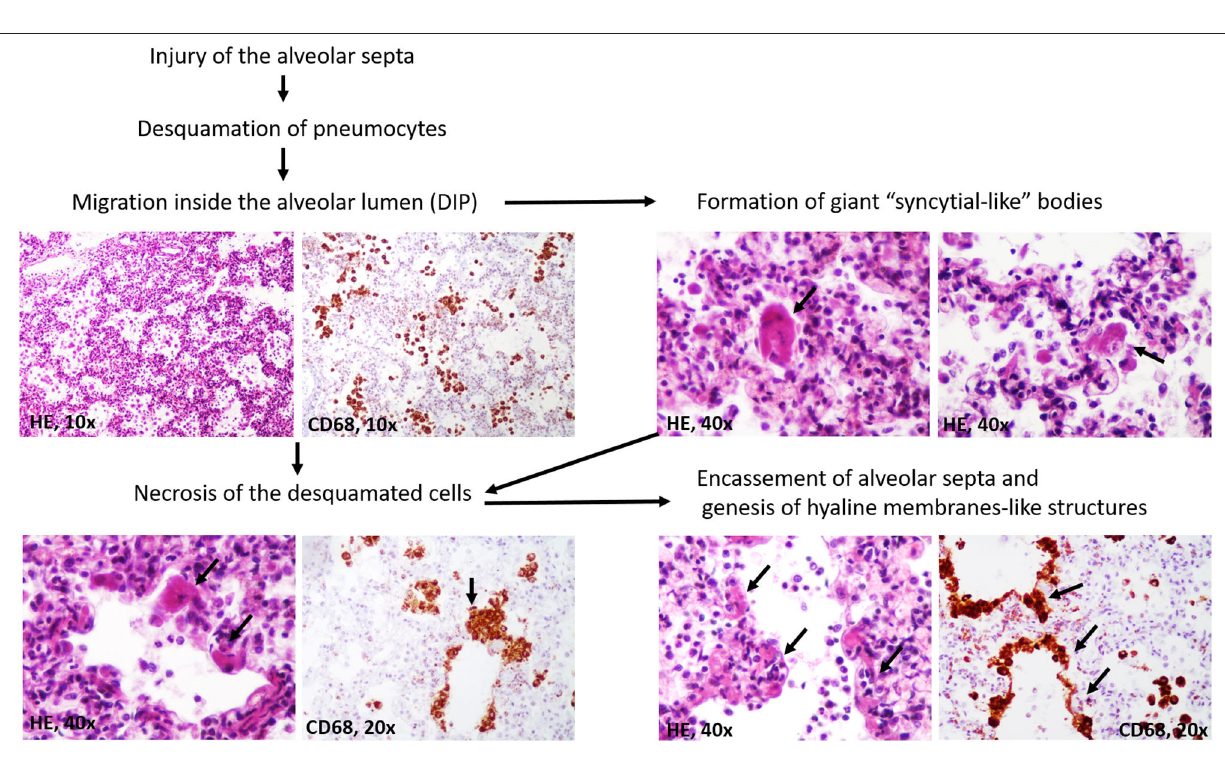
FIGURE 3 | Stepwise genesis of hyaline-membrane-like structures, in desquamative interstitial pneumonia